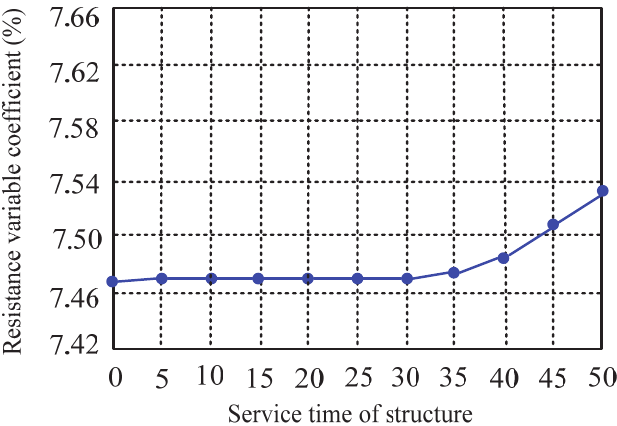
Figure 3. Time varying curve of variation coefficient of